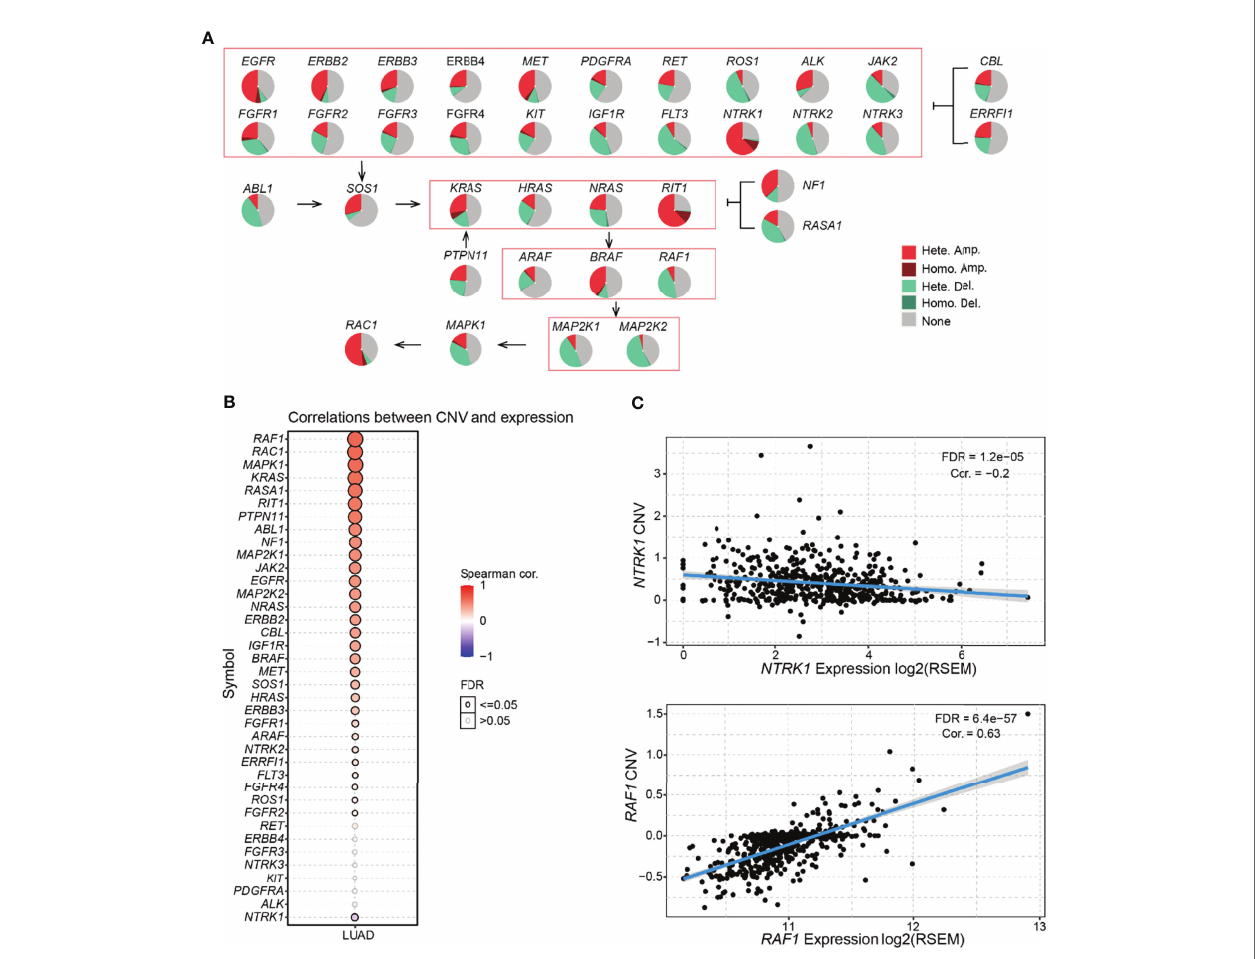
FIGURE 2 | Frequency and class of CNV of the RTK/RAS pathway and its in fl uence on mRNA expression. (A) Summary of the frequency of four CNV types in RTK/ RAS pathway genes. Hete.: heterozygous; Homo.: homozygous; Amp.: ampli fi cation; Dele.: deletion. (B) Spearman correlation between the CNV and mRNA expression of RTK/RAS pathway genes. Blue and red bubbles represent negative and positive correlations, respectively. Bubble size is positively correlated with the FDR signi fi cance. The black outline borders indicate FDR ≤ 0.05. (C) The scatter plot, with a fi tted line shows the detailed relationship between mRNA expression and CNV of NTRK1 and